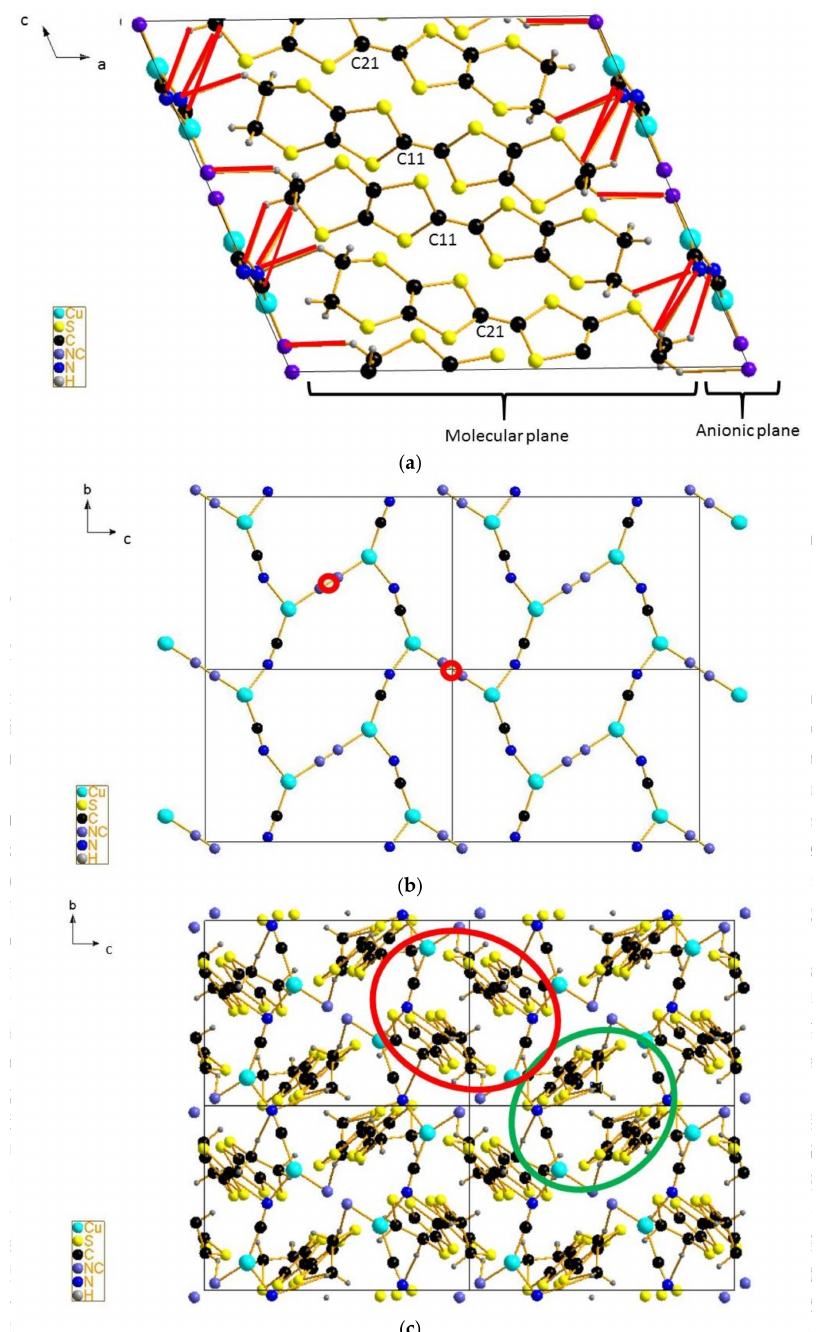
Figure 3. ( a ) (color online) Structure of κ -ET-Cu at 300 K viewed along the b -axis. For clarity purpose, only the most probable staggered C 2 H 4 group configurations are represented. In the molecular layer, the first number of the atom labels (1 or 2) refers to the two different types of molecules and are indicated for the Ci1 atoms only. The hydrogen bonds (red lines) of the ethylene groups (S conformation) with the N and disordered N/C atoms in the anionic plane are also shown; ( b ) View of the anionic plane parallel to the ( b , c ) plane: the disordered C–N groups, which are located on the inversion centers (red circles), are colored in violet; ( c ) View of the anionic ( b , c ) plane and the molecular layer below showing Dimer 1 (green) and Dimer 2